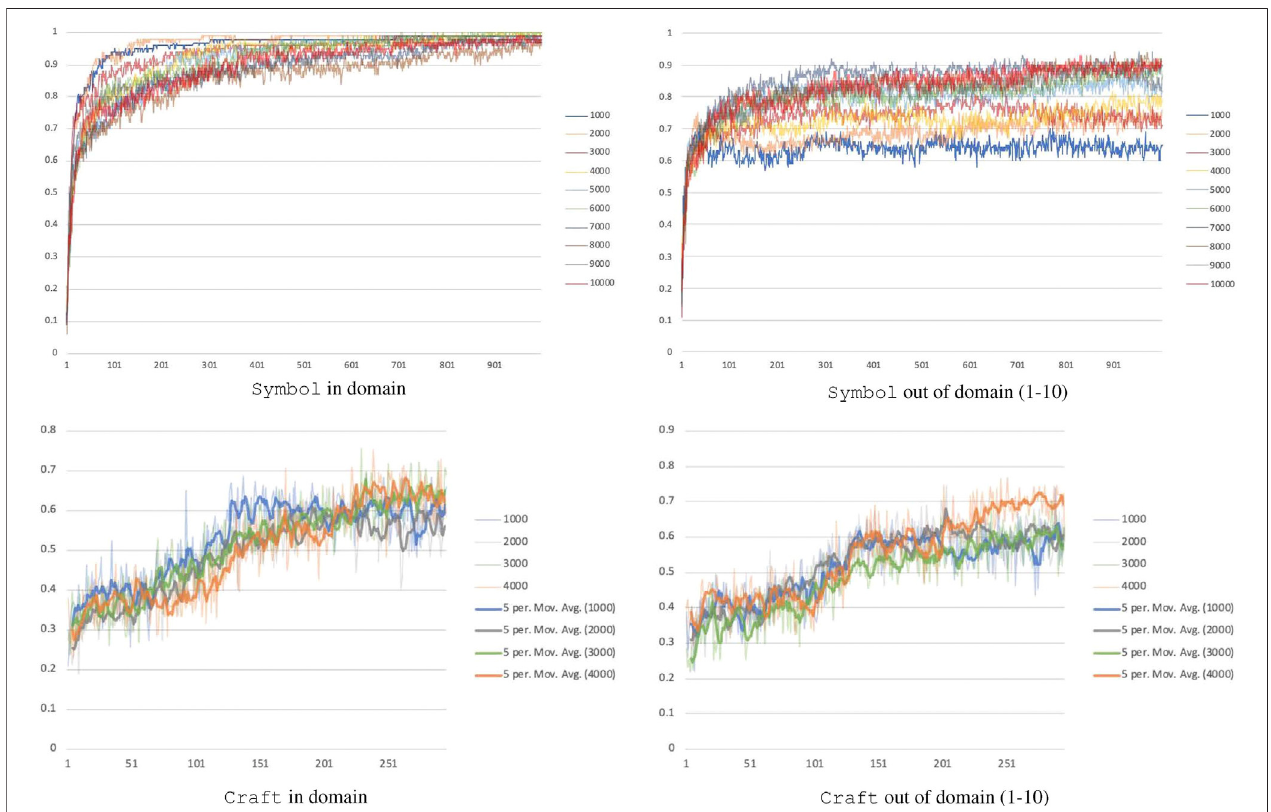
FIGURE4| Performanceofthemodelasthenumberoftrainingformulasincreases.The x -axisisthenumberofmodelupdatesperformed,eachunitis200updates for Craft and 500 updates for Symbol. Note that any minor error made while executing the formulas was considered a failure.